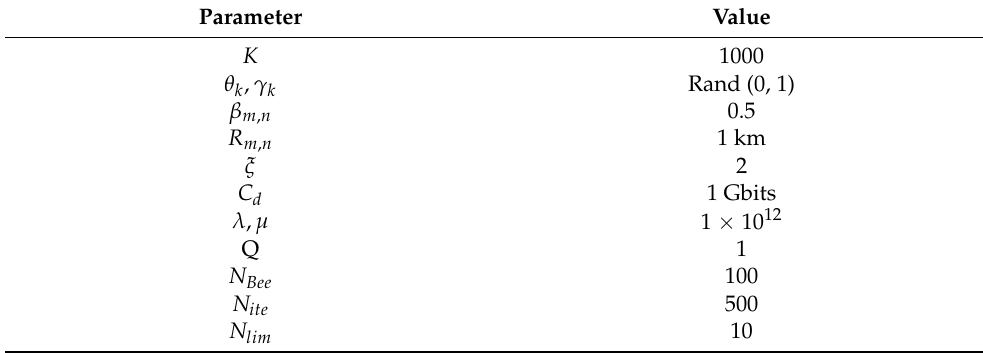
Table 1. Simulation parameters.